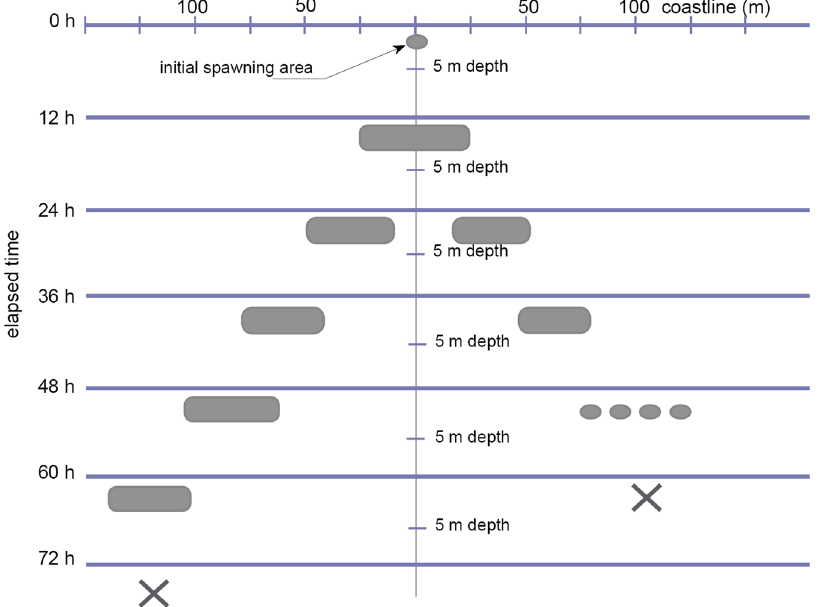
Figure 4. Diagrammatic illustration of the development of a Lithophaga lithophaga synchronised spawning area. Spawning was initiated by either one or a few individuals and progressively affected spatially close neighbours. Such a reproductive wave might finally spread over several hundred metres of coastline and last longer than three days.